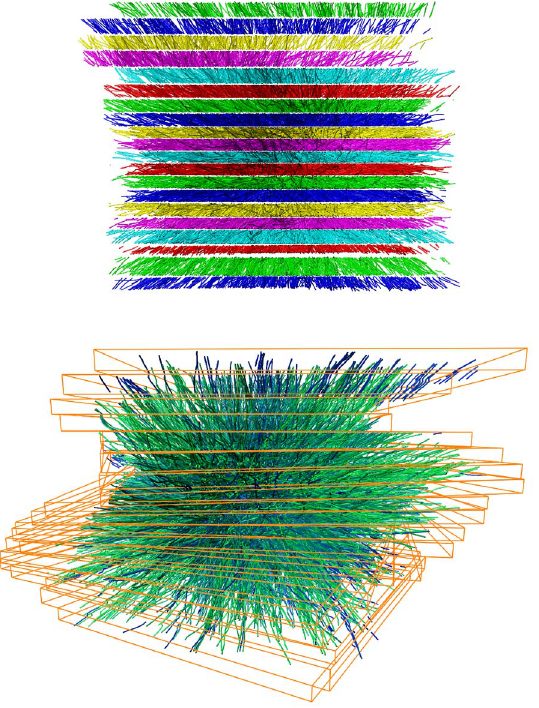
Figure 1. Starting point and output of our computational methods. Results are displayed for a stack of 3 00 nm thick and 5 m m wide sections of microtubule centerlines in the mitotic spindle of a C. elegans early embryo. Each section contains approximately 1500 microtubules, which were traced in electron tomograms. Top: Side view of unaligned centerlines before stitching. Colors indicate different sections. Bottom: Perspective view of the stitched microtubules after applying our algorithms. Color indicates length of the stitched microtubules: greenish lines are longer; bluish lines are shorter. The orange bounding boxes help getting an impression of the alignment transformation. The boxes were oriented parallel to the main coordinate axes before alignment. Some lines do not have a continuation in the next section (for example bluish lines at top right), because the area covered by the tomograms varied from section to section.